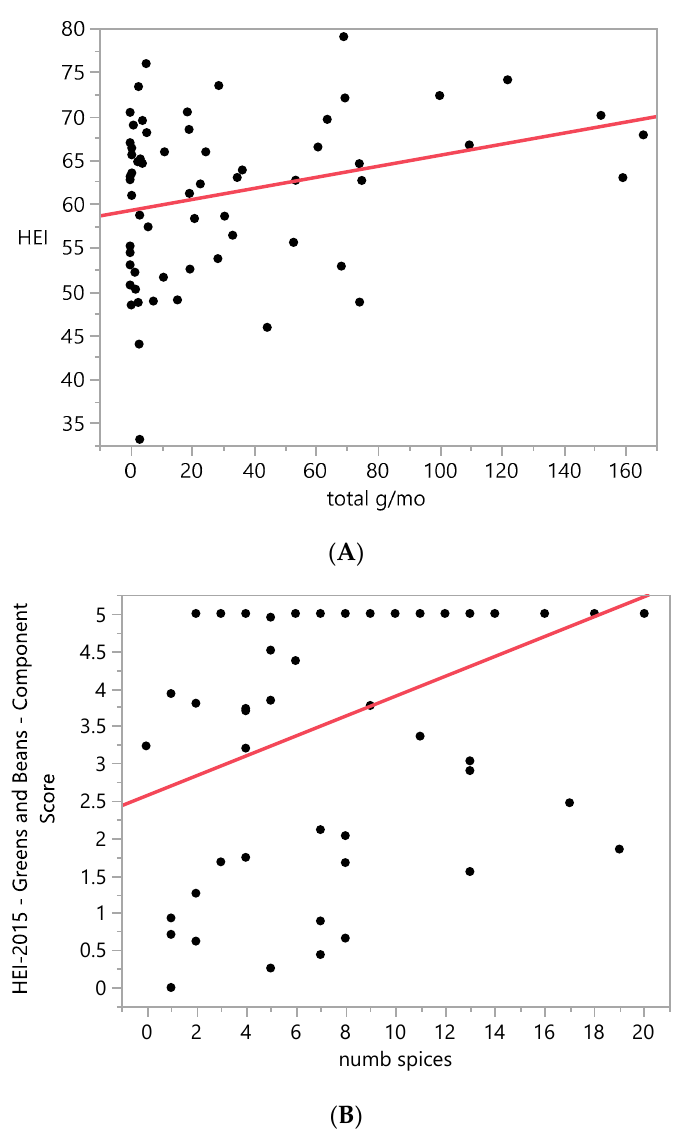
Figure 3. Correlations between Herb and Spice Questionnaire measurements and Healthy Eating Index-2015 score. ( A ) Correlation between total g/mo consumption of herbs/spices as recorded by the Herb and Spice Questionnaire (HSQ) and Healthy Eating Index-2015 (HEI) total score. N = 62. Pearson correlation coefficient = 0.3, p < 0.05. ( B ) Correlation between HEI Greens and Beans component score and number of herbs/spices consumed per month as recorded by the HSQ. Pearson correlation coefficient = 0.4, p < 0.0001. N = 62.